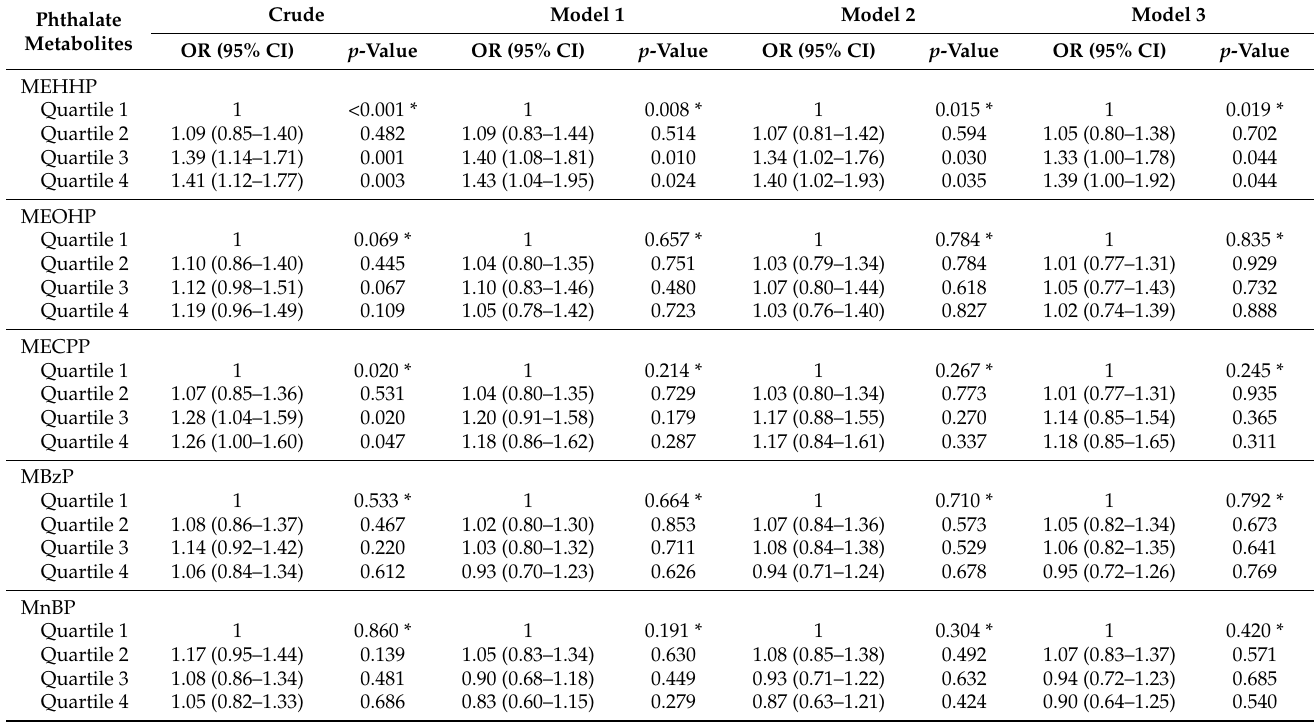
Table 3. The association between hepatic steatosis index score and urinary phthalates levels (ug/L).